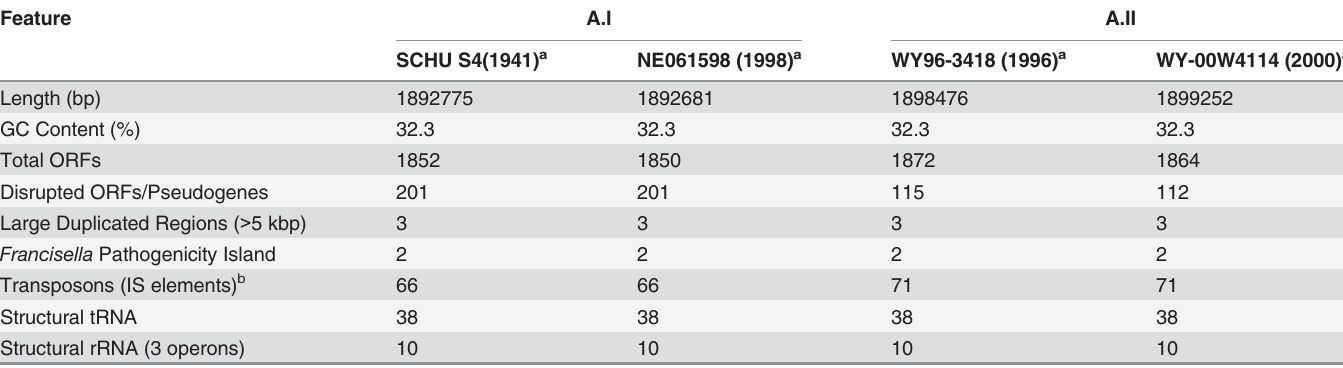
Table 3. Overall genomic features of F . tularensis subtype A.I and A.II strains.